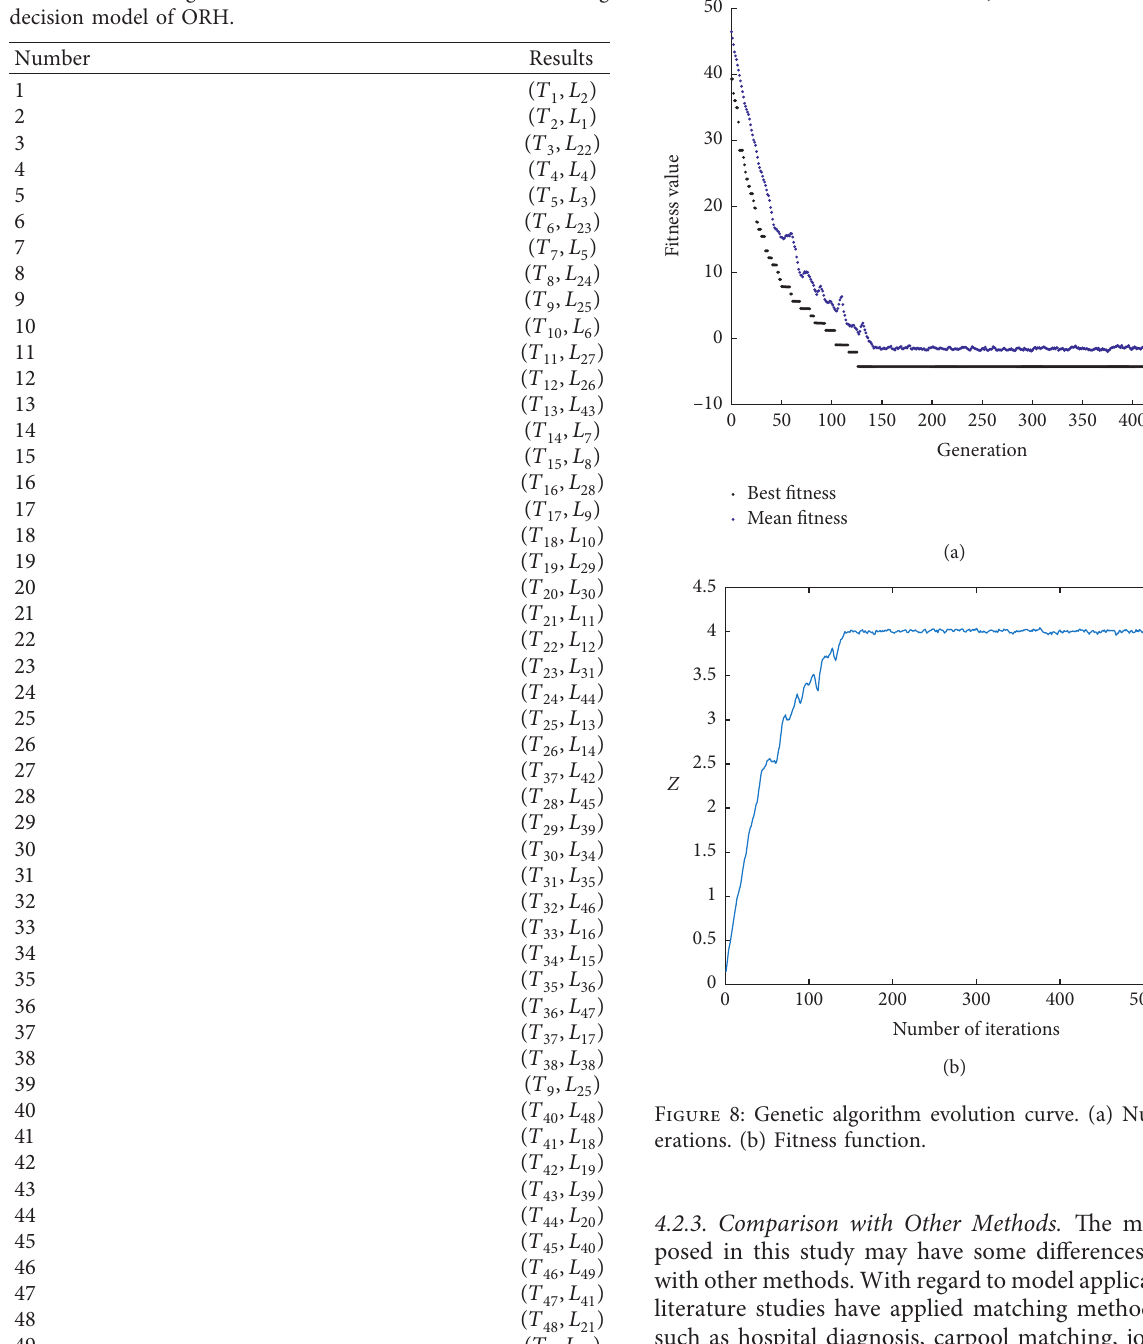
Table 20: Matching results of the multiattribute SAD matching decision model of ORH.